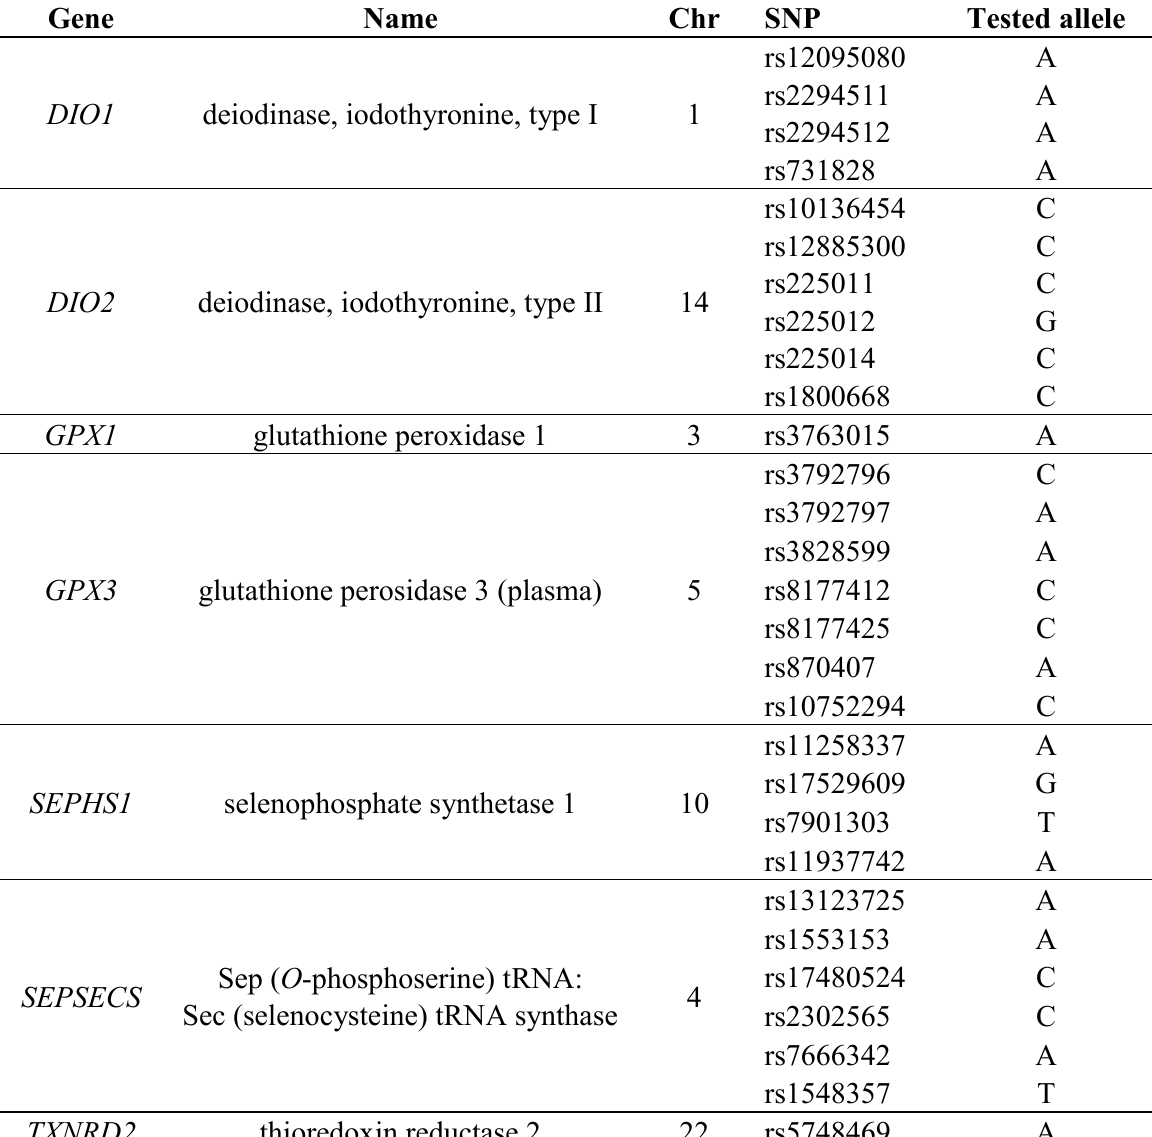
Table 4. List of SNPs tested in this